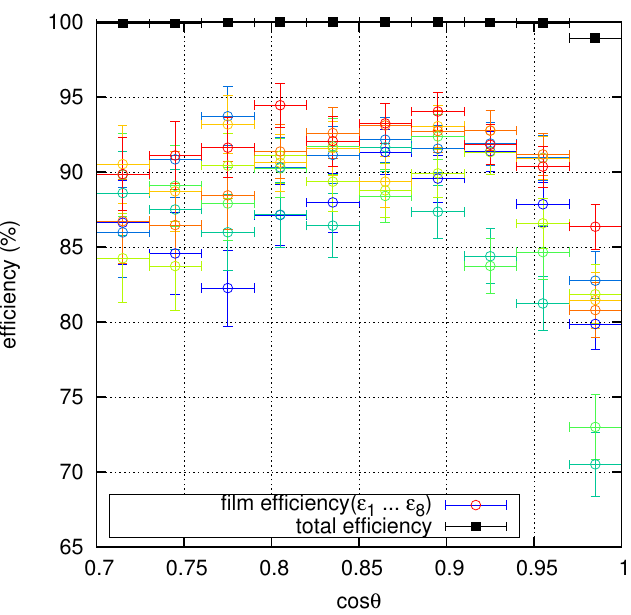
Figure 13. Base-track efficiency for each film in a module as a function of the track angle (open circles); different colors account for the eight films in a module. Track reconstruction efficiency (black squares).